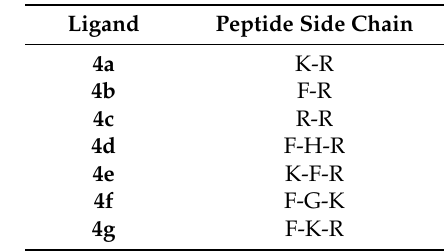
Table 1. Structures of the synthesized 9-peptidyl palmatine derivatives ( 4a – 4g ).